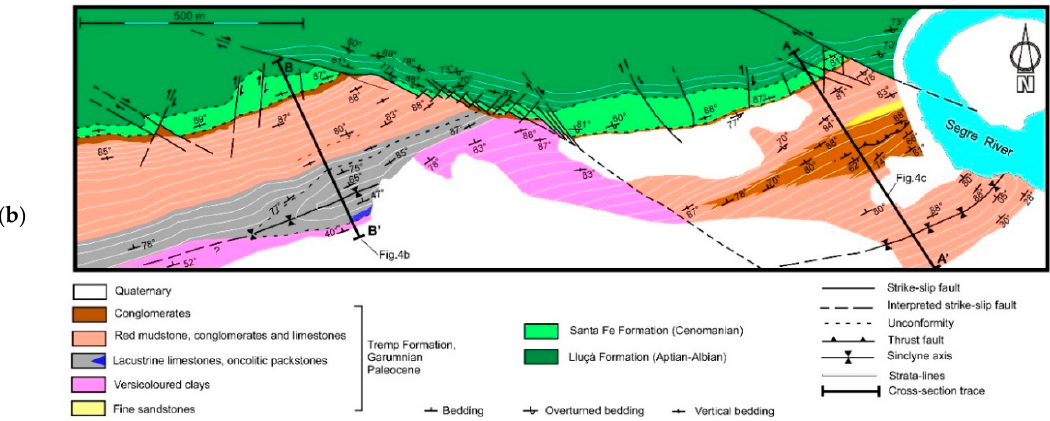
Figure 3. ( a ) Aerial view with sample location (yellow numbers) and situation of Figures 5, 8 and 9. Figure 7a, representing the Bóixols thrust outcrop, is about 11 km to the west of the Coll de Nargó village. ( b ) Geological map of the main outcrop. The Paleocene syn-orogenic sequence (Garumnian facies) fossilizes the Bóixols thrust in this area. Location in Figure 1. A-A’ and B-B’ cross sections in Figure 4. Minerals 2018 , 8 , x FOR PEER REVIEW